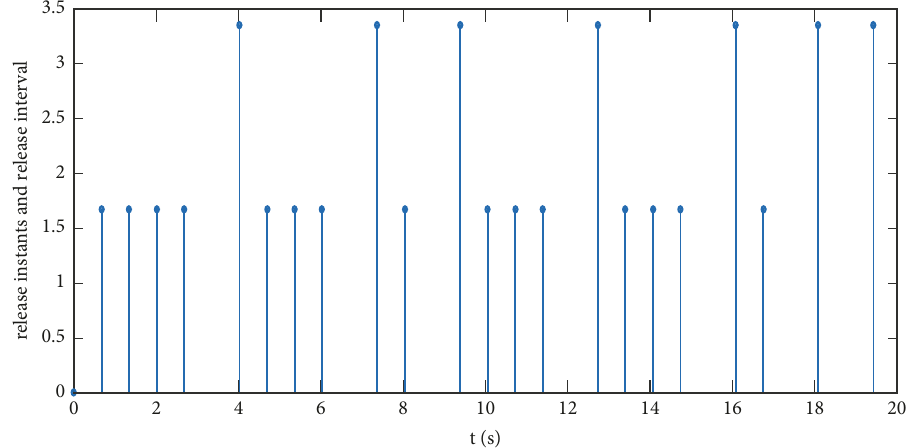
Figure 3: Improved static event-based release interval and release instants,